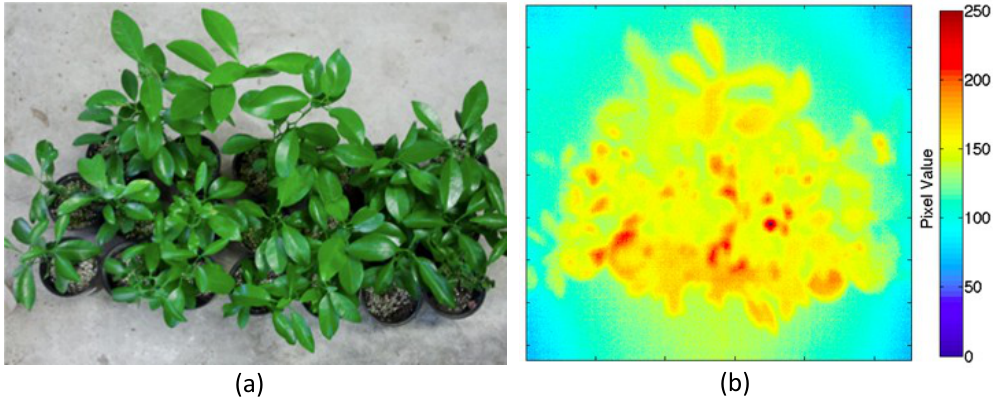
Figure 2. ( a ) RGB and ( b ) thermal images of Shekwasha seedlings with varying degree of stress.